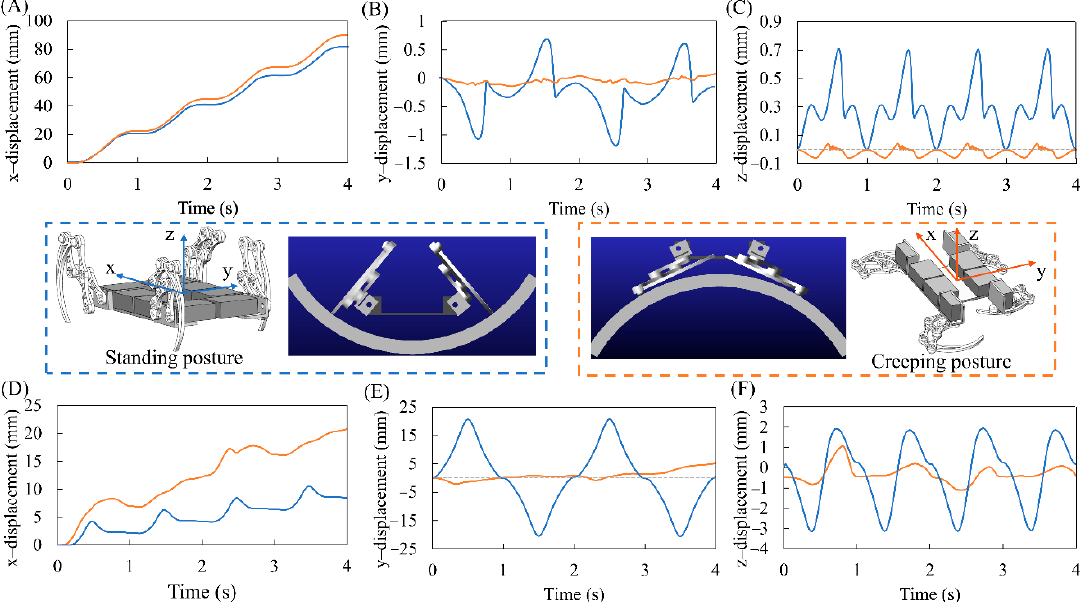
Figure 8. Simulation analysis of robot locomotion (t blue curve represents the upright state of the limbs, and the red curve represents the prostrate state of the limbs). ( A ), ( B ), and ( C ) are the displacements of the robot in the x, y, and z directions of the plane locomotion, respectively; ( D ), ( E ), and ( F ) are the displacements of the robot in the x, y, and z directions when it moves on the arc surface, respectively (the blue curve represents the locomotion of the inner surface, and the red curve represents the crawling locomotion on the outer surface).